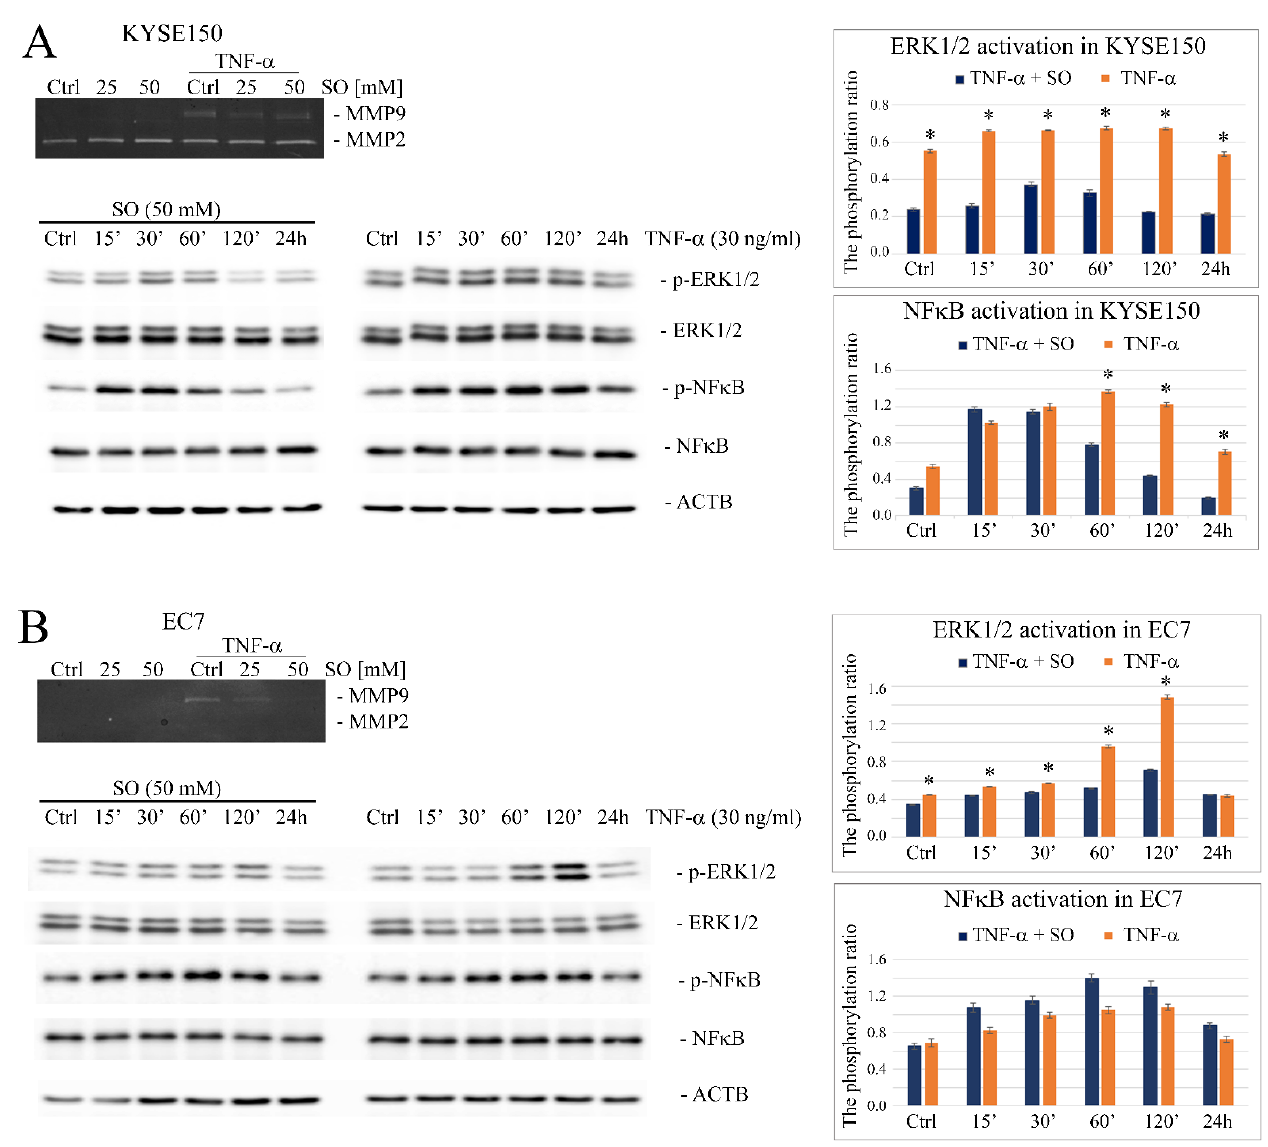
Figure 7. The effect of sodium oxamate on activation of TNF- α -induced MMP9-related ERK1/2 and NFκB signaling pathways in esophageal cancer cells. SO-dependent downregulation of MMP9 in response to TNF- α, seen in gelatin zymography (upper), and time corse of ERK1/2 and NFκB/p65 phosphorylation after TNF- α stimulation in ( A ) KYSE150 cells and ( B ) EC7 cells treated or not with SO (50 mM) for 24 h, visualized by Western blotting. Quantitative analysis using the differential densitometry of TNF- α - induced ERK1/2(Thr202/Tyr204) and NFκB/p65(Ser536) activation in the form of bar graphs, showing the ratio of phospho-proteins normalized to total protein in SO-treated and non-treated cells (right panels). Ctrl — control; SO — sodium oxamate; ACTB — β -actin/loading control; * p < 0.001.